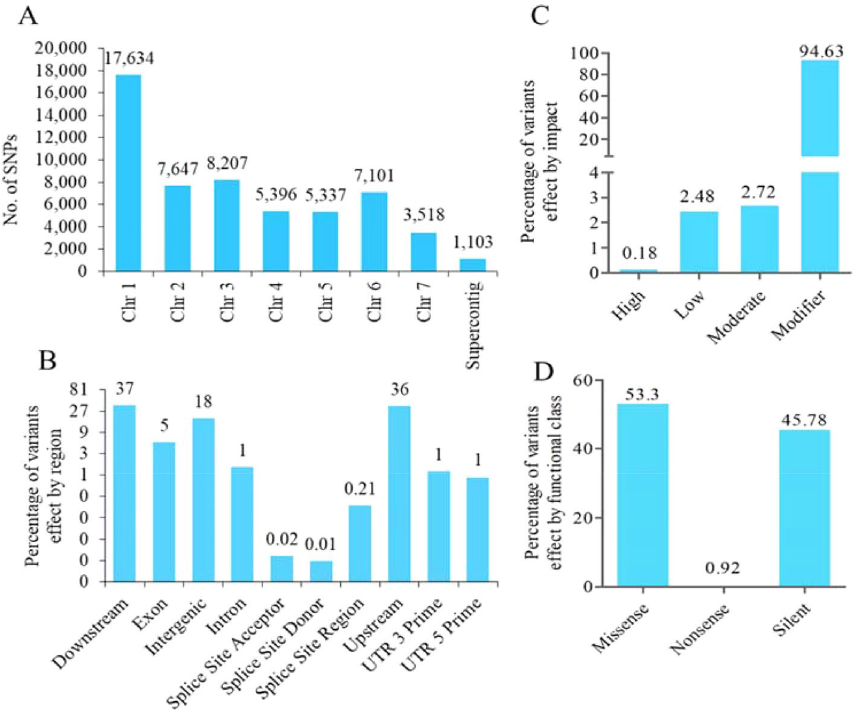
Figure 9. Identified variants and effect annotation of M. oryzae RMg_Dl genome. A = variants distribution by chromosome, B = effect by different region, C = effect by impact and D = effect by functional